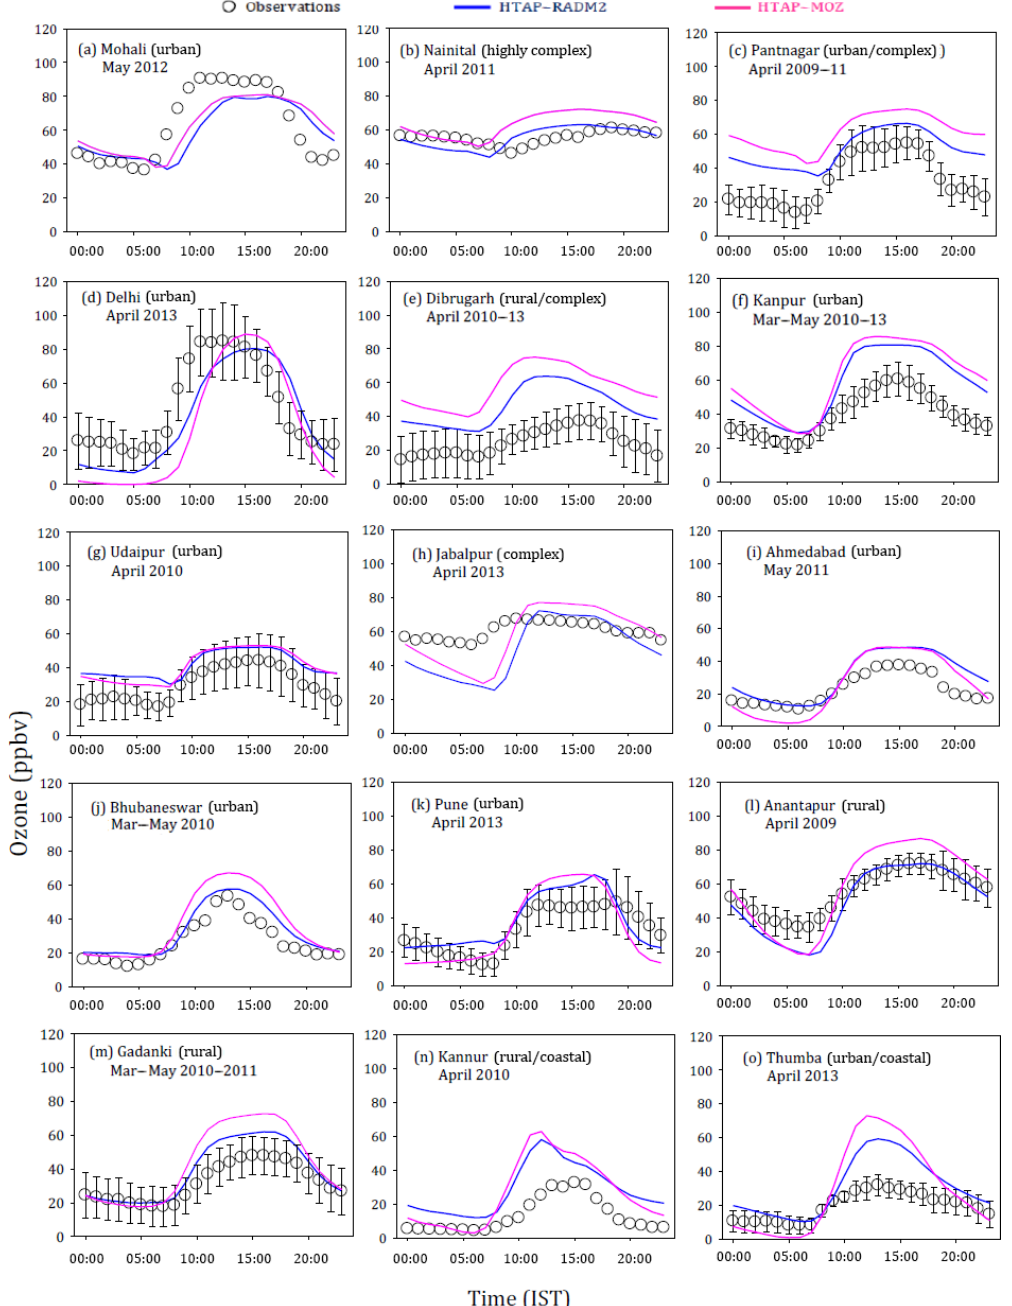
Figure 11. Comparison of monthly average diurnal variation of surface ozone simulated using different chemical mechanisms at various observation sites. The observational data are available for the period indicated in the figure, whereas all the model simulations are for the year 2013. Error bars represent the temporal SDs of the monthly averages. All model simulations are with the HTAP